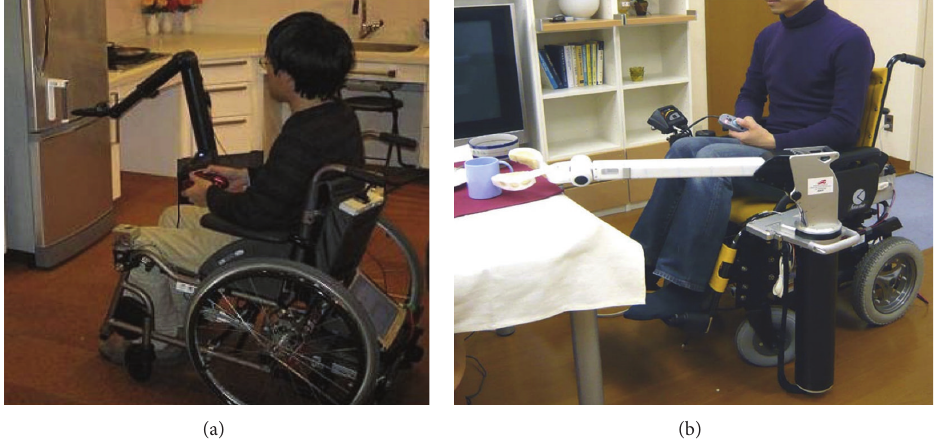
Figure 8: Assistive robotic arms: iARM (a) and RAPUDA (b).